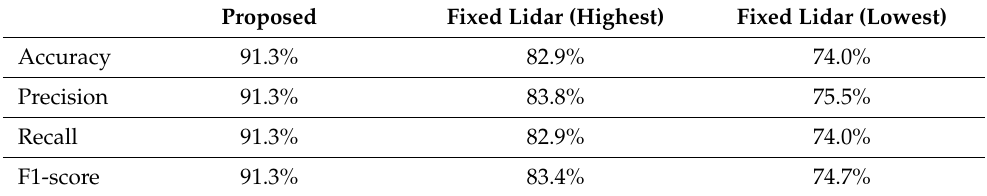
Table 8. Comparison of the classification metrics between our proposed method and that of [4]. Proposed